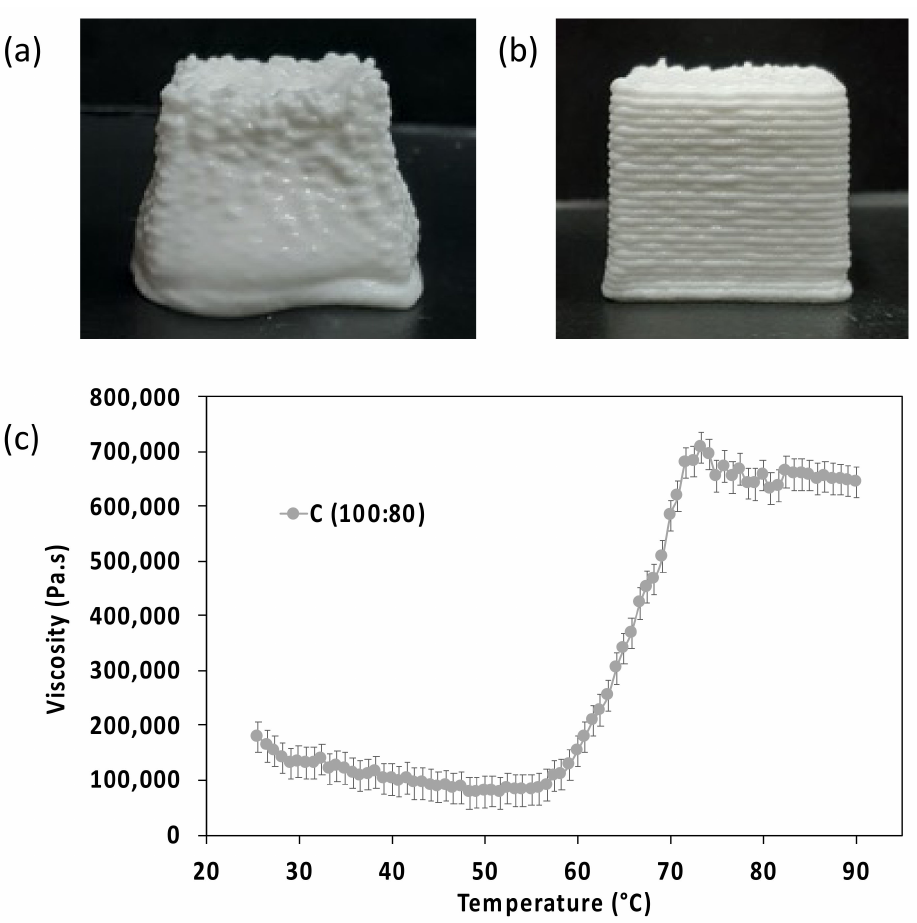
Figure 9. Structural stability of rice paste model: ( a ) sample printed at room temperature (28 ◦ C), ( b ) sample printed at controlled printing temperature (47 ± 5 ◦ C), and ( c ) sample viscosity changes with increasing